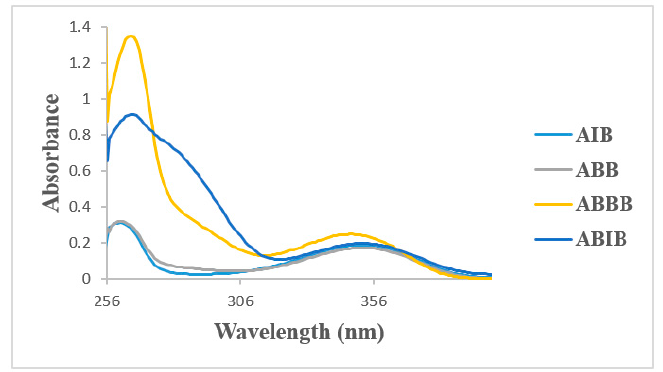
Figure 3. UV-Vis spectra of ABB, AIB , ABBB , and ABIB in DMSO (conc. = 1 × 10 − 6 mol/L).